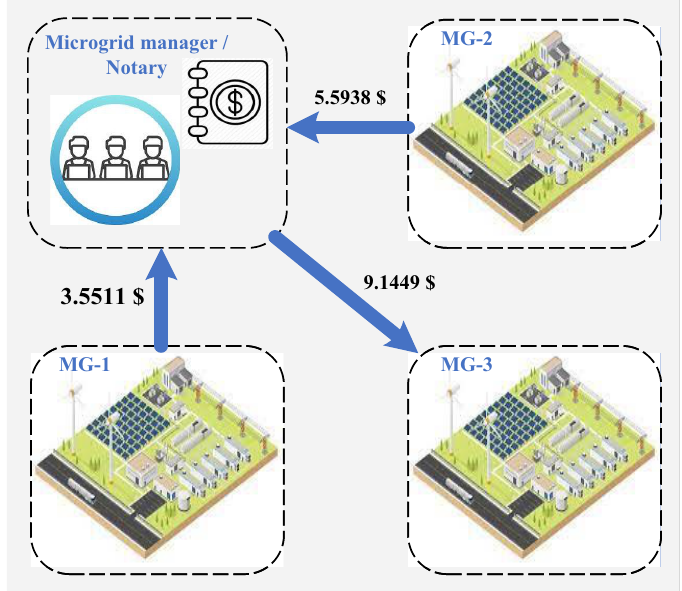
Figure 10. Local electricity market clearing results.